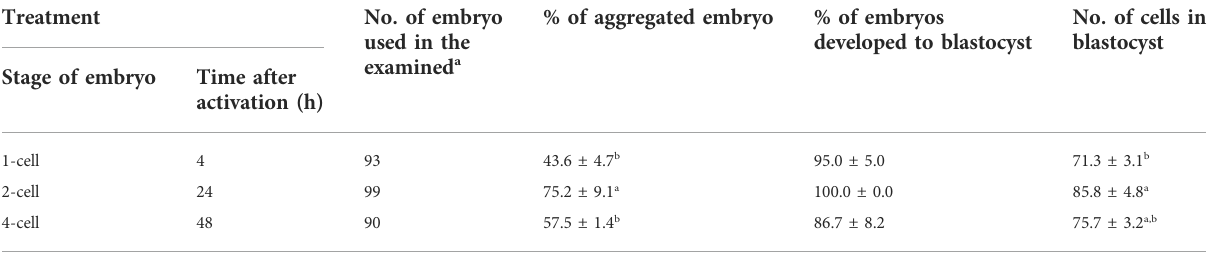
TABLE 1 Effects of Phytohemagglutinin (PHA-L) on the aggregation ef fi ciency and developmental competence of parthenogenetic embryos in pigs. Treatment